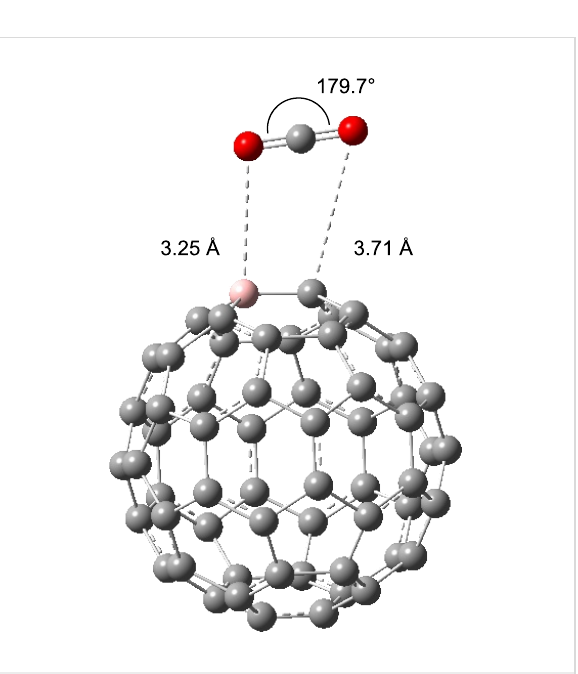
Figure 2: Configuration of physisorbed CO 2 on neutral BC 59 . Atom colour code: grey, carbon; pink, boron; red, oxygen.